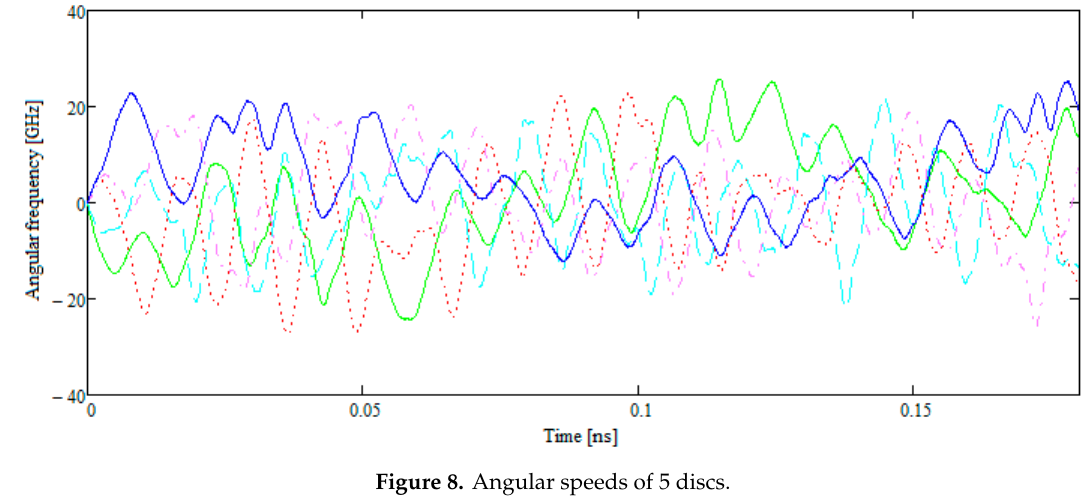
Figure 8. Angular speeds of 5 discs.